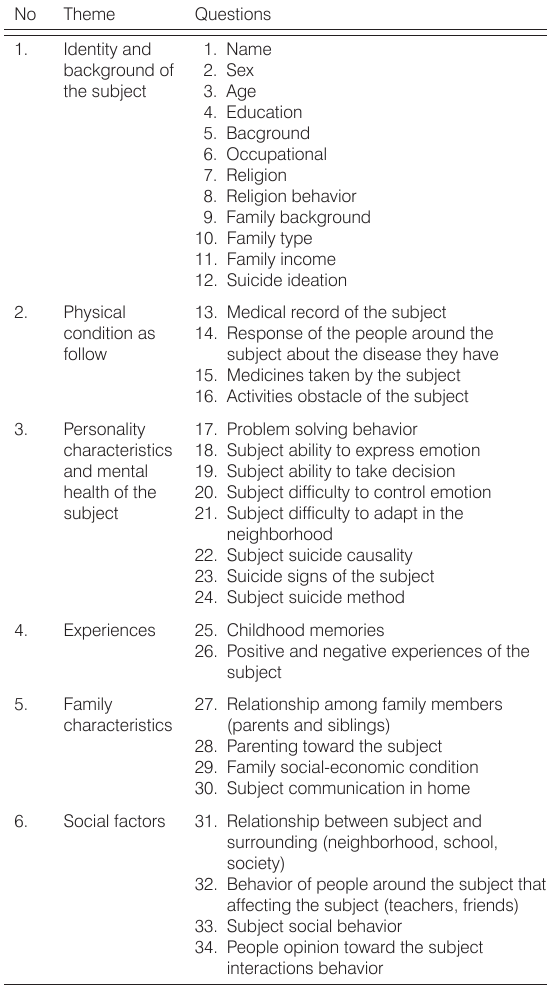
Table 1. The questions from the